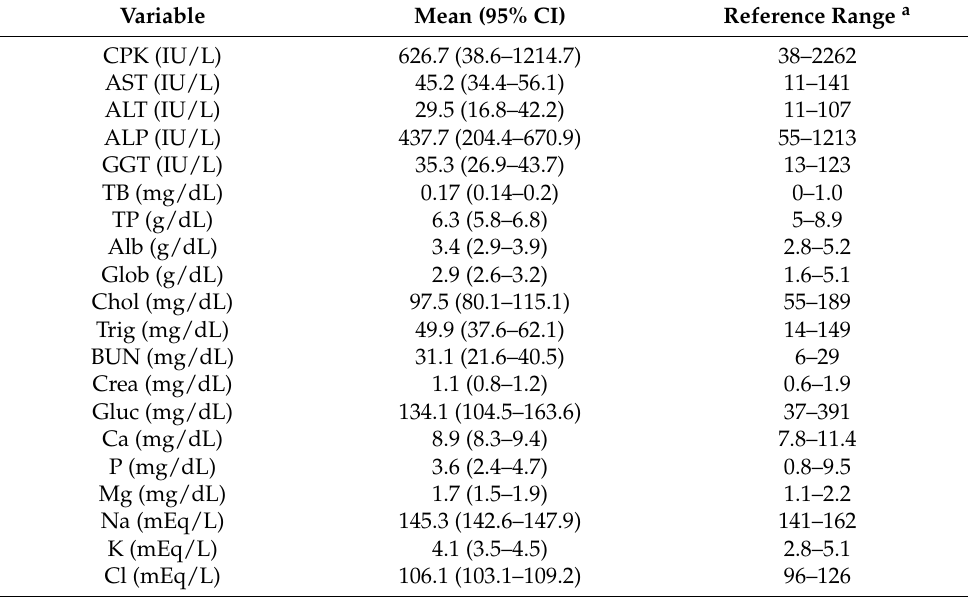
Table 2. Biochemical profile (mean and 95% CI) in 11 baboons ( Papio hamadryas ) 15 min after intramuscular injection with tiletamine-zolazepam and